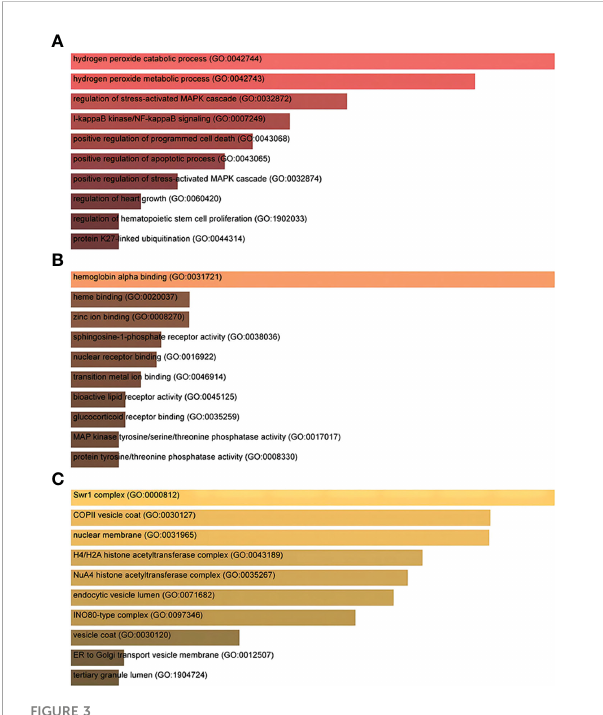
FIGURE 3 The ontological bar graphs of the DEGs that are shared among SARS-CoV-2, AKI, and CKD using the Enricher online tool. The GO function is divided into three parts: (A) biological processes, (B) molecular function, and (C) cellular component. Each bar graph represents a function in GO. DEGs, differentially expressed genes; SARS-CoV-2, severe acute respiratory syndrome coronavirus 2; AKI, acute kidney injury; CKD, chronic kidney disease; GO, Gene